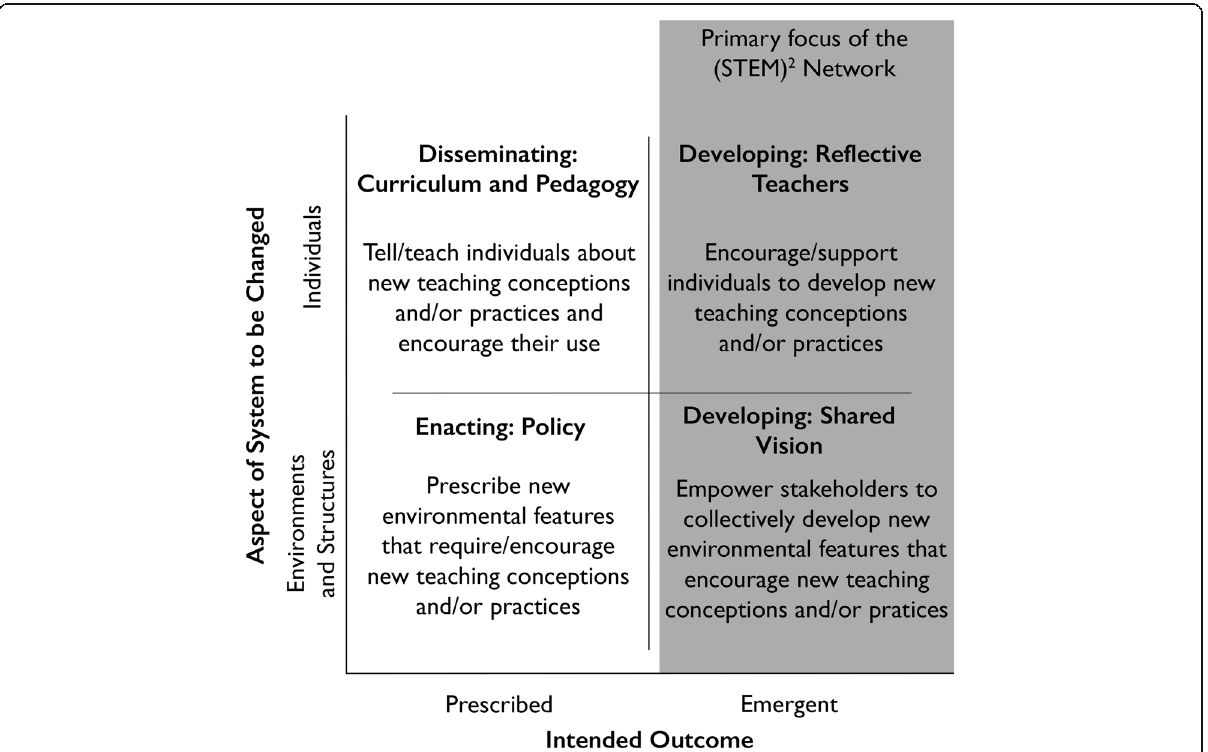
Fig. 3 (STEM) 2 Network and the four change strategies described in Henderson et al. (2010). The (STEM) 2 Network primarily focuses on emergent outcomes that impact the individuals and the environments and structures in which they teach. Figure modified from Henderson et al.